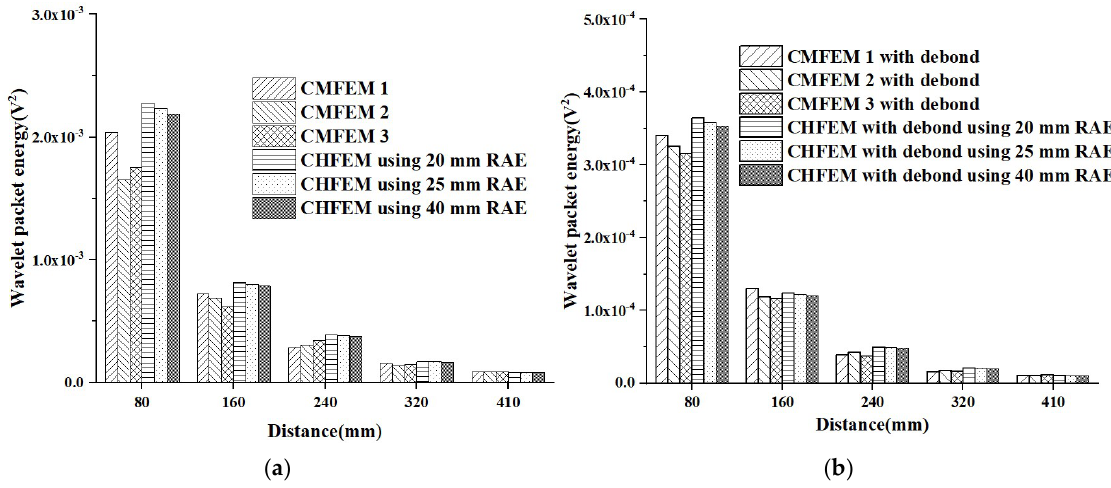
Figure 14. Comparison of the responses of PZT sensors between CMFEMs and CHFEMs corre- sponding to CMFEM 1 with different RAE sizes under sinusoidal signals. ( a ) Healthy CMFEMs and CHFEMs, and ( b ) CMFEMs and CHFEMs with an interface debond defect.